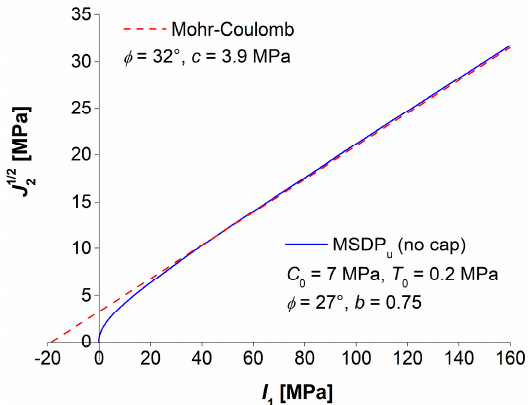
Figure 7. The open MSDP u yield surface (no cap) and corresponding Mohr ‐ Coulomb surface in I 1 – J 21/2 plane (for θ = 0°).